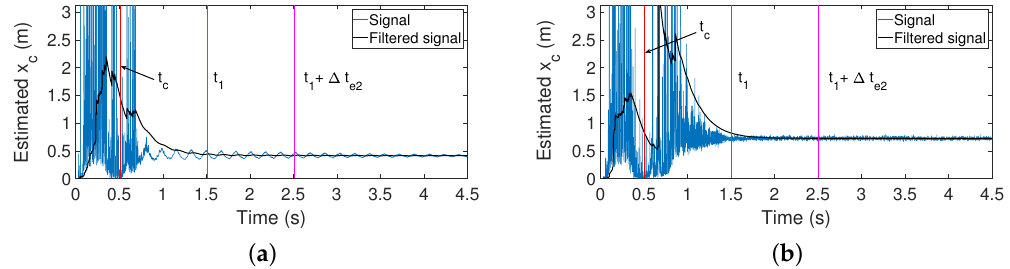
Figure 14. Estimator based on the torque/force ratio: ( a ) contact point 0.4 m; ( b ) contact point 0.85